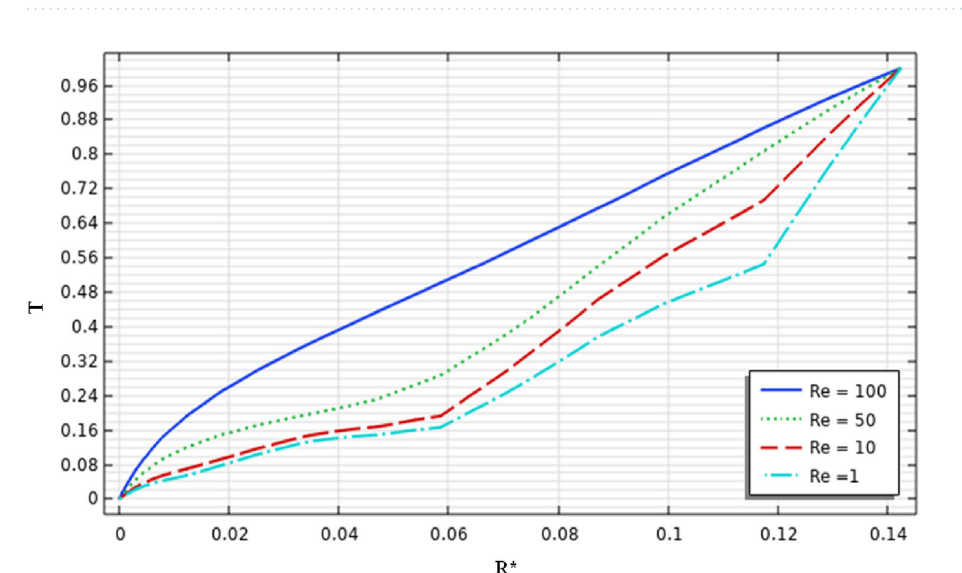
Figure 14. Temperature distribution on the vertical axis of the